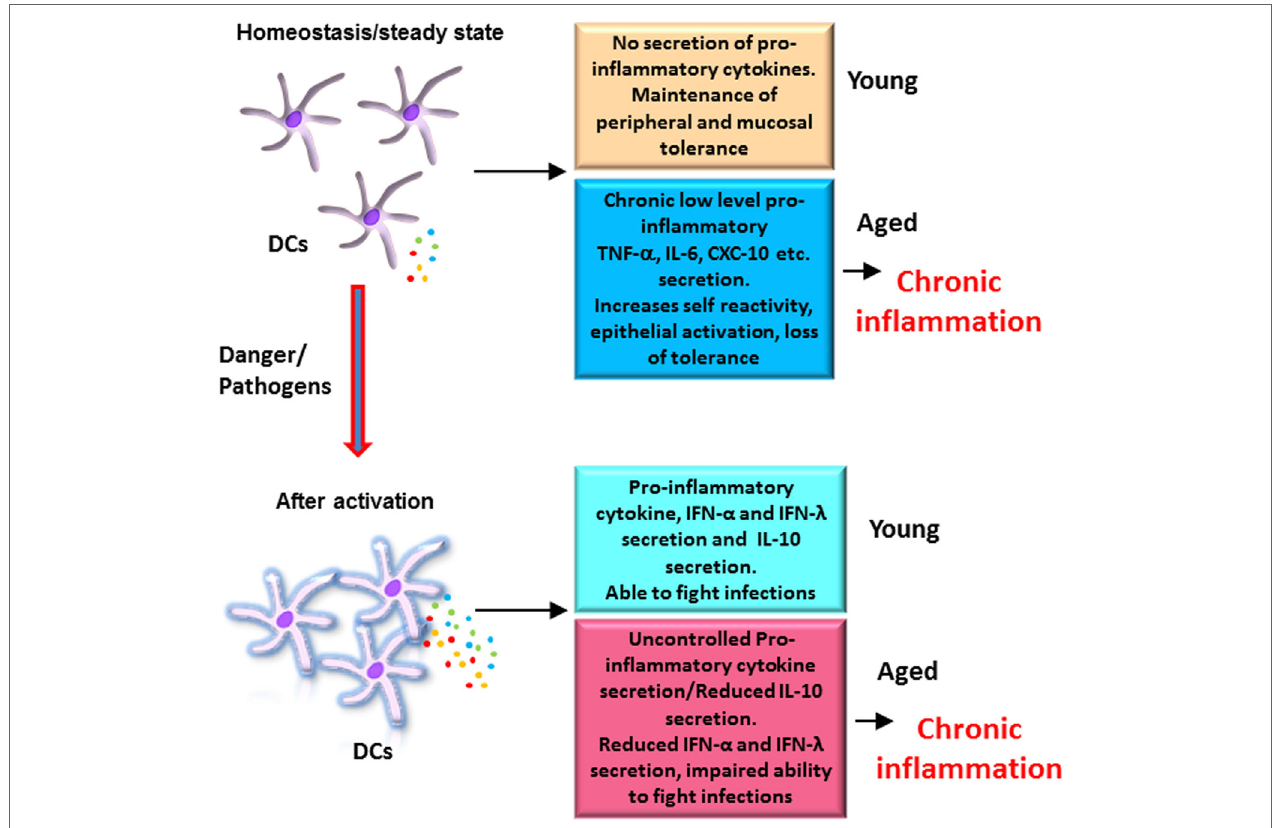
FiGURe 1 | Altered functions of dendritic cells (DCs) from elderly contribute to chronic inflammation: DCs from elderly display an enhanced basal level of activation, which increases their reactivity to self-antigens, affects the function of epithelial barrier, and results in erosion of peripheral and mucosal tolerance at homeostasis. After activation with pathogens, DCs from elderly secrete enhanced levels of pro-inflammatory cytokines, which are not regulated as the secretion of anti- inflammatory cytokine IL-10 is impaired. This also contributes to inflammation. In addition, secretion of protective cytokines such as the IFN- α and IFN- λ is also decreased resulting in a decrease in the ability of elderly to fight infections. Figure depicts the differences in the response of DCs from aged and young subjects at homeostasis and after